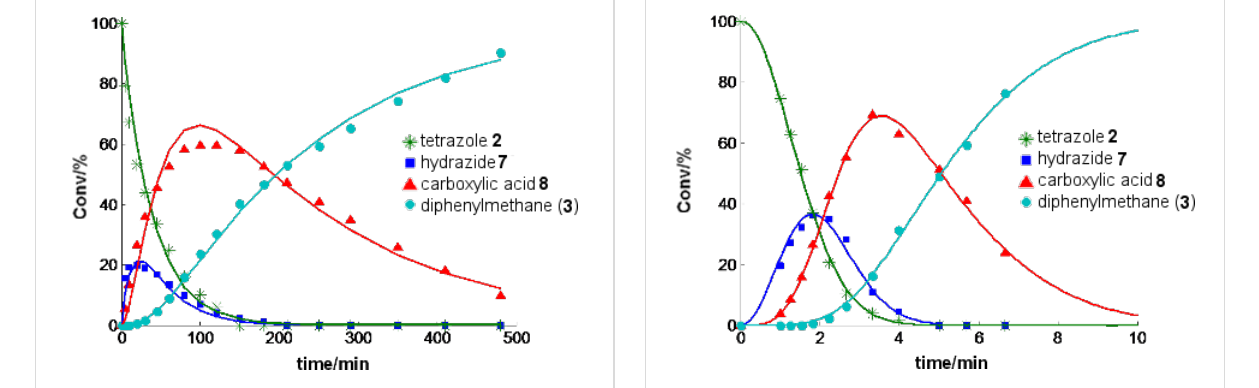
Figure 3: Decomposition of tetrazole 2 at 240 °C in a NMP/AcOH/H 2 O 5:3:2 mixture (0.125 M) (points: experimental results; solid lines: predicted with a rate law according Scheme 3 with k 1 = 1.11 × 10 − 3 , k 2 = 0.432 × 10 − 3 and k 3 = 0.0832 × 10 − 3 s − 1 ). Conversions in percent were derived from HPLC-UV (215 nm) peak area integration without correction for response factors. The corresponding conversions for 250 °C and 260 °C and additional data are shown in the Supporting Information File 1 (Figures S2–S4).